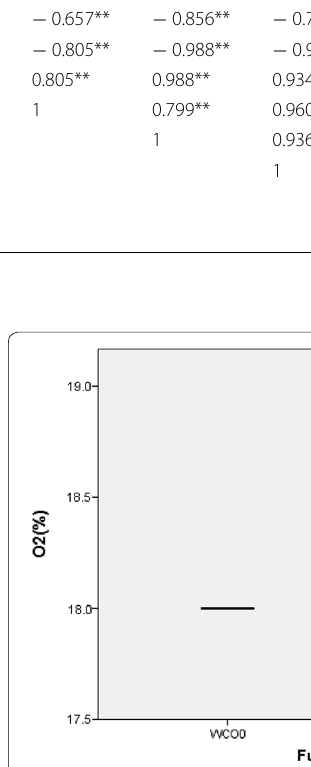
Fig. 3 Box plot diagrams of driving and exhaust characteristics [O 2 emission (Unit: %)]